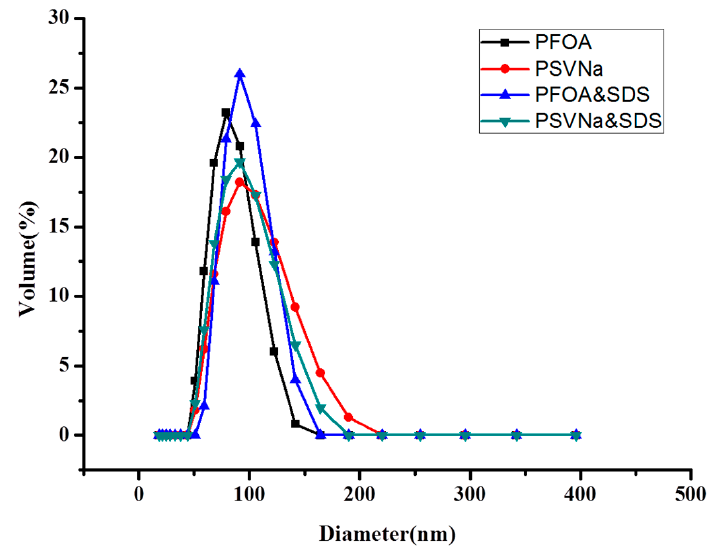
Figure 6. Particle size and distribution of fluorinated acrylate latex with different emulsifier.